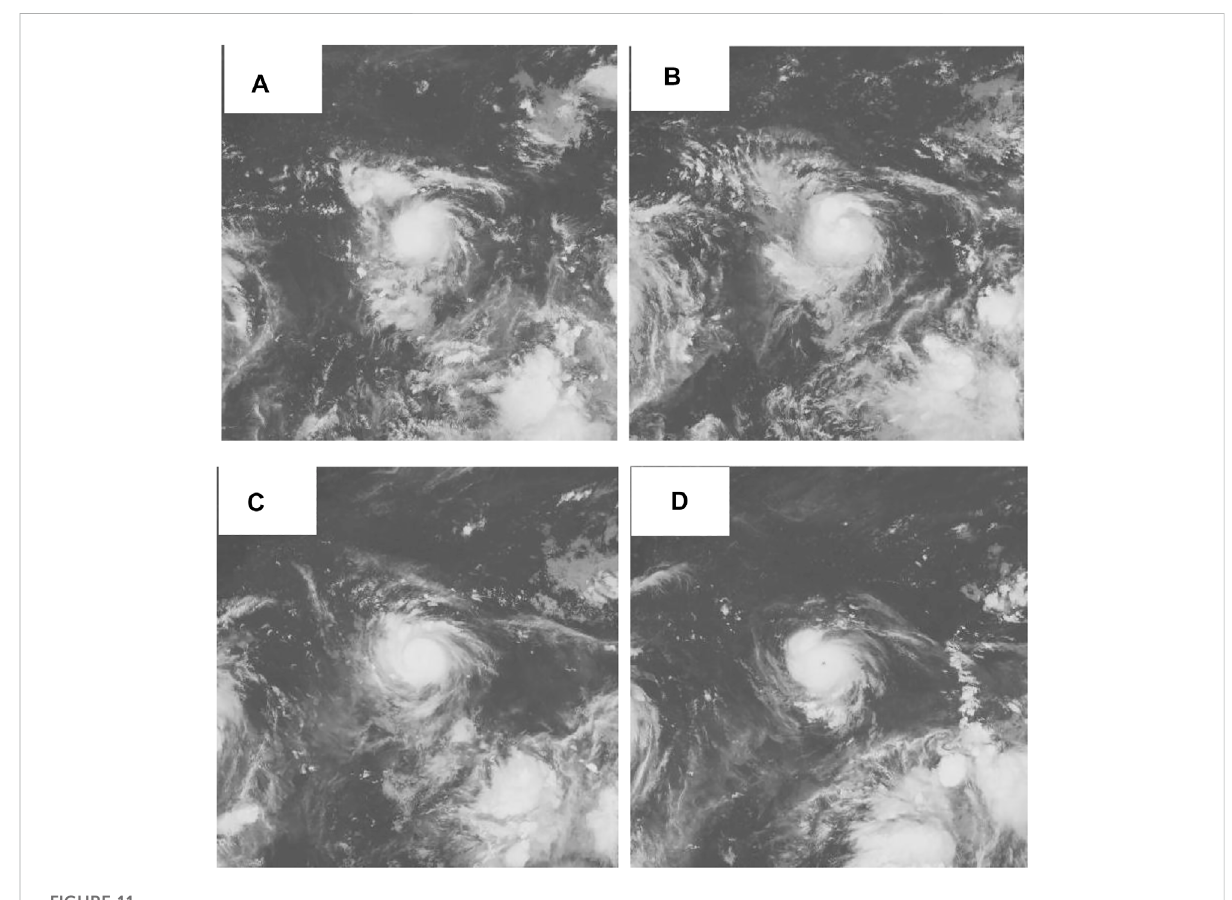
FIGURE 11 SatelliteremotesensingcloudmapsofTyphoon2114atfourconsecutivetimes (A) 00UTCon7September2021 (B) 06UTConSeptember7 (C) 12UTC on September 7 (D) 18UTC on September